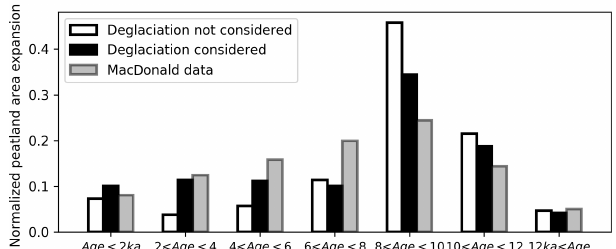
Figure 13. Grey bars show the percentage of observed peatland ini- tiation in 2000-year bins. Peat basal dates of 1516 cores are from MacDonald et al. (2006); peat basal age frequency of each 2000- year bin is divided by the total peat basal age frequency. White bars show the percentage of simulated peatland area developed in each 2000-year bin; deglaciation of ice sheets is not considered (the model was run with SubC six times, 2000 years each time). The peatland area developed in each bin is divided by the simulated modern (the year 2009) peatland area. Black bars show the percent- age of simulated peatland area developed in each 2000-year bin; pattern and timing of deglaciation are read from maps in Figs. S5 and